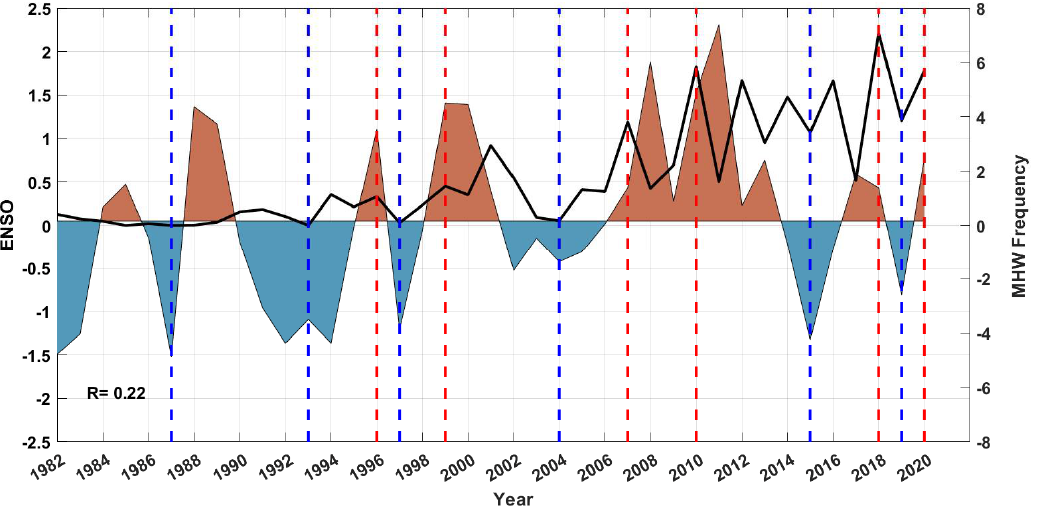
Figure 7. The annual normalized time series of El Niño-Southern Oscillation (ENSO) (left y -axis) and total MHW frequency (events) (right y -axis) over the study period (1982–2020). The vertical dashed red lines indicate the positive phase of ENSO (El Niño), and the vertical dashed blue lines indicate the negative phase of ENSO (La Niña).